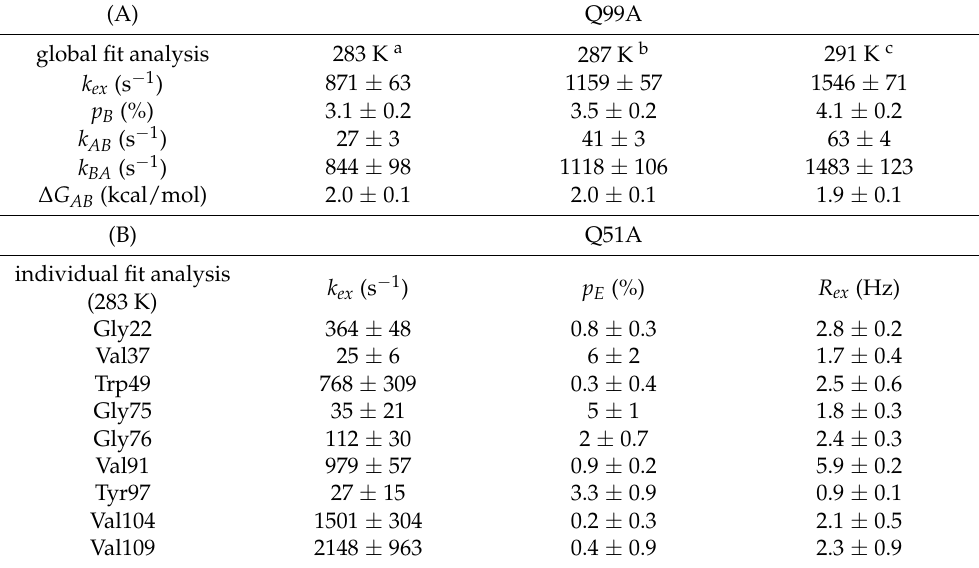
Figure 7. Backbone 15 N chemical shift differences between the ground and higher energy states. ( A ) Values of | Δδ | along the amino acid sequence as derived from CPMG relaxation dispersion meas ‐ urements on wild ‐ type (circle) and Q99A (quadrangle) apo human I ‐ BABP with parameters listed in Table 2. For residues involved in global fluctuation at faster (cluster I) and slower (cluster II) ex ‐ change rates, values of | Δδ | are depicted in closed and empty symbols, respectively. Secondary structure elements are shown at the top. ( B ) Residues exhibiting a decrease (green) or increase (pur ‐ ple) in | Δδ | exceeding 20% in the mutant relative to the wild ‐ type form are highlighted on the rib ‐ bon diagram of apo human I ‐ BABP (PDB: 1O1U [15]). The position of the mutation is indicated in black.